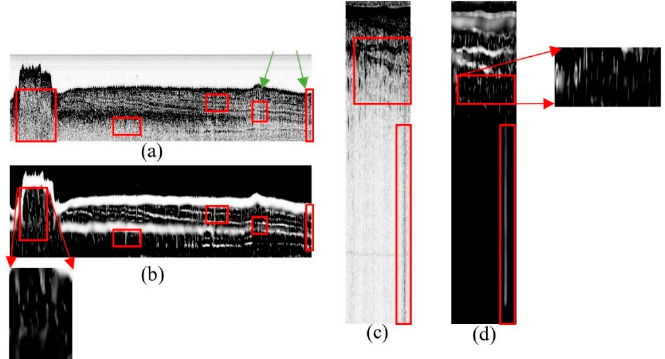
Figure 4. Illustration of vertical structure enhancement using the multi-resolution filtering method. ( a , c ) show the original SBP image. ( b , d ) show the filtered image using multi-scale enhancement filtering method directly. Some vertical structures are marked with rectangles in the figure. Areas with imbalanced gray levels are pointed by the green arrows.